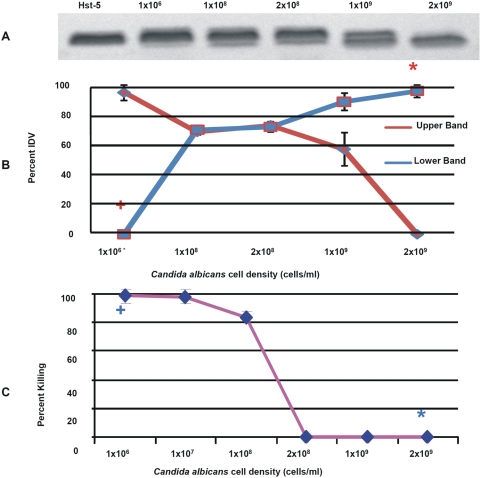
Degradation and killing potency of Hst-5.(A) Degradation of Hst-5 by C. albicans demonstrating degradation level proportional to cell density (cells/ml). (B) Decrease in the percent Integrated Density Value (IDV) of the intact Hst-5 (upper band) (P<0.02) and increase in density of degradation product (P<0.0001) (lower band). (C) Percent killing demonstrating significant killing + of C. albicans at 1×106 cells/ml density correlating with no degradation + at that cell density; whereas no killing* at 2×109 cells/ml correlates with significant degradation*. Error bars indicate the standard errors of the means.